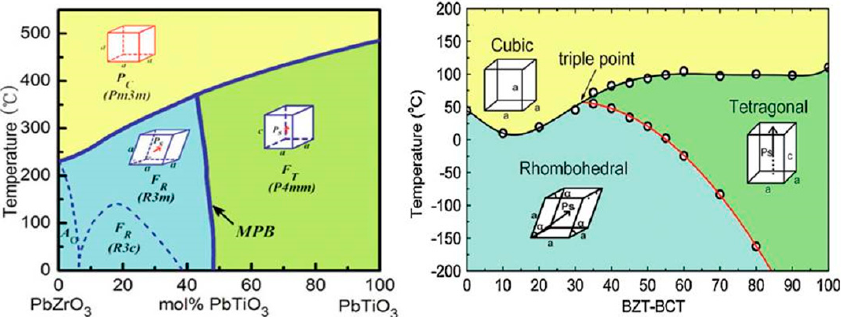
Figure 8. The comparison of phase diagram for PbZr 1 − x Ti x O 3 ( left ) and Ba(Zr 0.2 Ti 0.8 )O 3 –(Ba 0.7 Ca 0.3 )TiO 3 ( right ) [14].